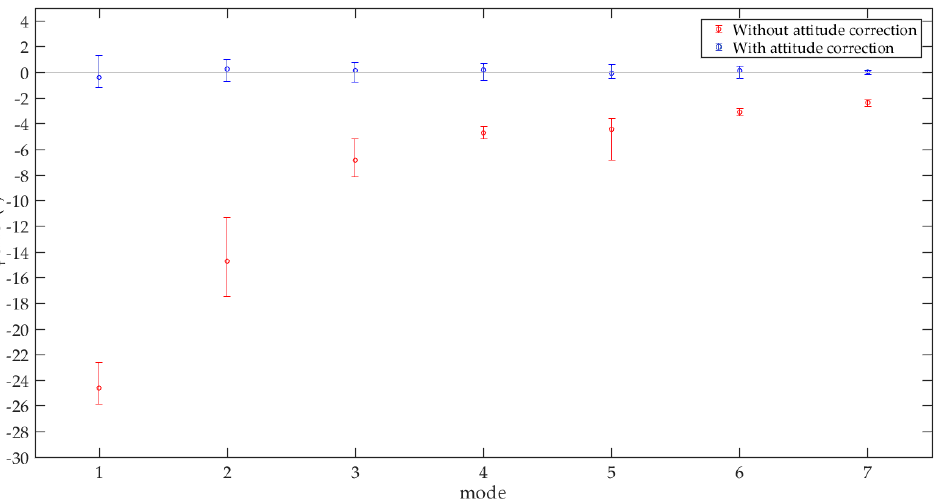
Figure 10. The maximum, average, and minimum values of angle φ error of 5 sampling points in each mode.